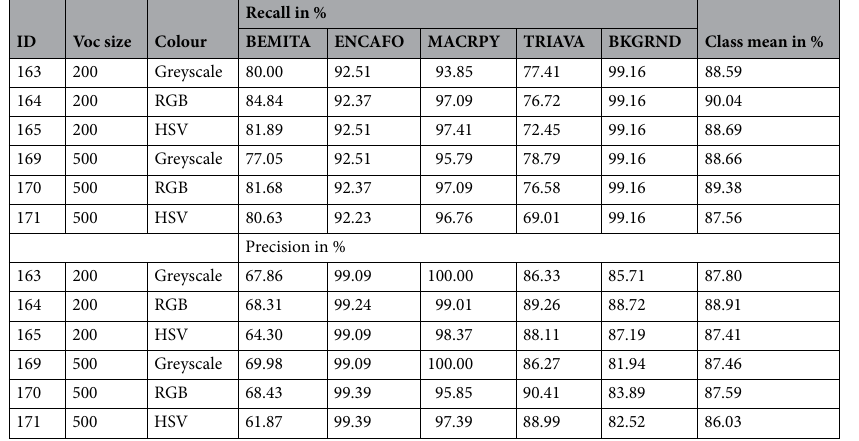
Table 2. Recall and precision of different models trained by k-d tree SVM-quantizer and SGD solver for different dictionary sizes (vocsize) and colour spaces (colour) based on a pooled dataset from Lab0d and Lab7d (temporal